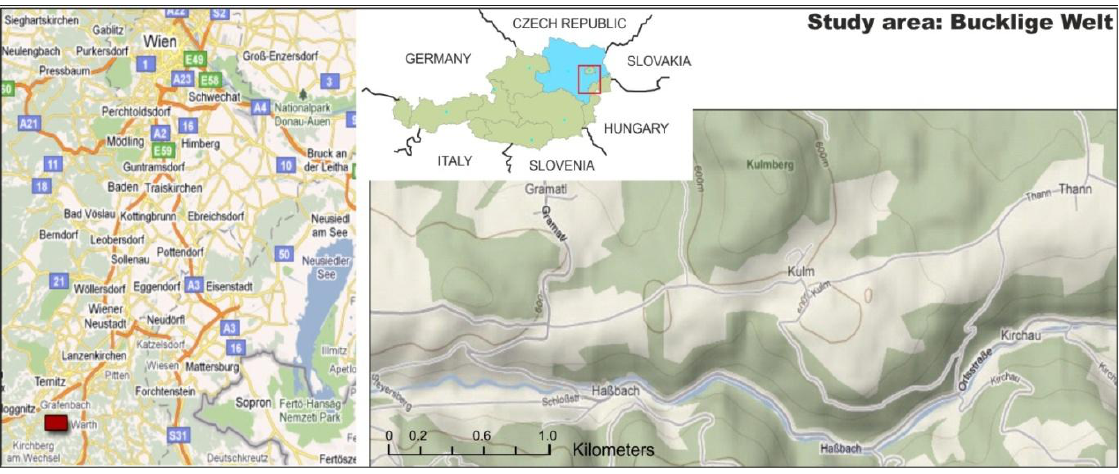
Figure 1. Study area Bucklige Welt , Lower Austria (UTM33N, LE: 578100, 5277900, UR: 582800,